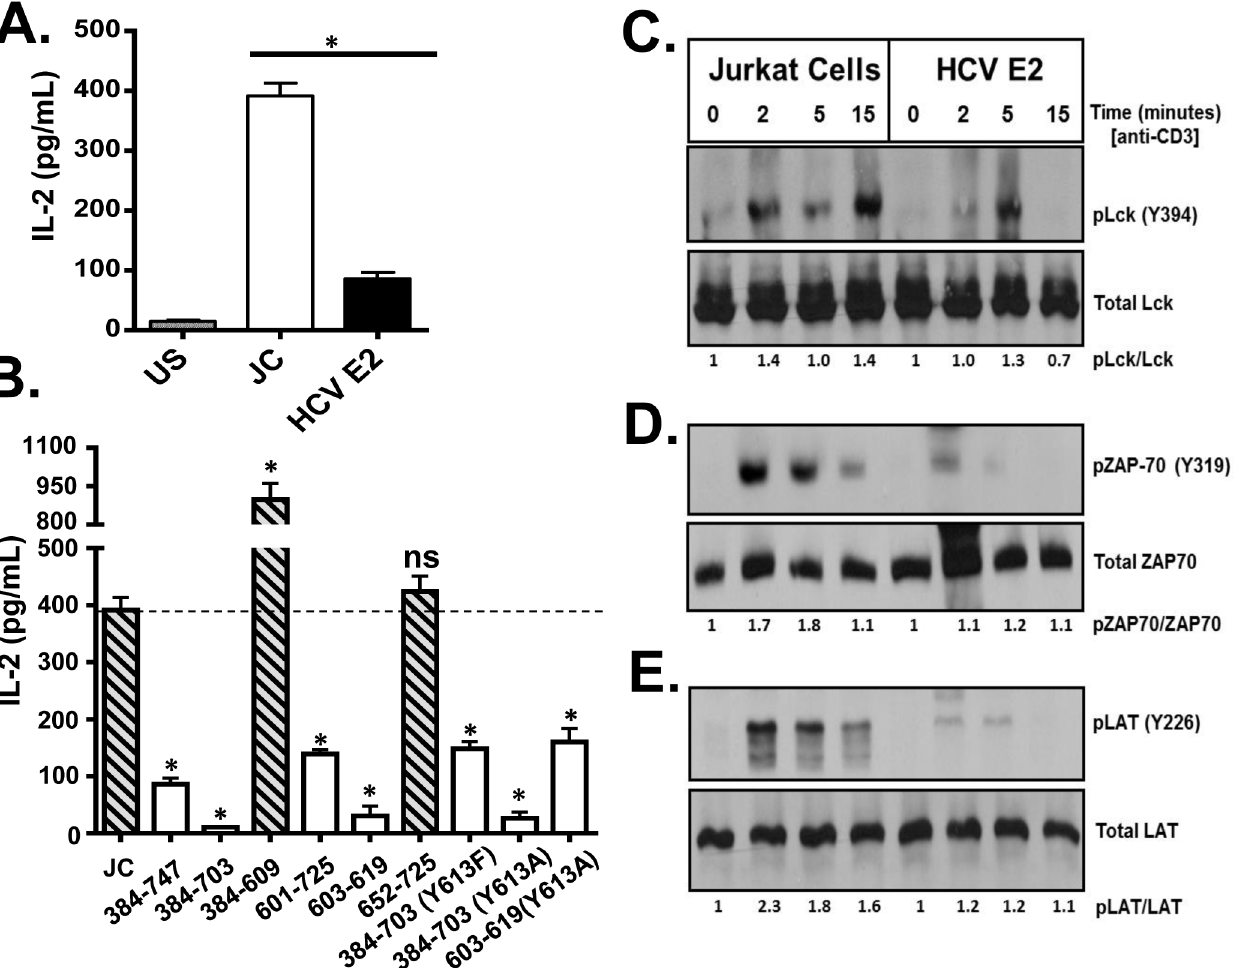
Fig 4. HCV envelope protein E2 inhibits T cell receptor (TCR)-mediated signaling. Jurkat control cells (JC) or Jurkat cells stably expressing HCV E2 protein were stimulated with anti-CD3 and anti-CD28. Twenty-four hours later, IL-2 release (A) was measured. Phosphorylation and activation of the lymphocyte specific tyrosine kinase (Lck Y394; B), the zeta-chain-associated protein kinase (ZAP)-70 (Y319; C) and linker for activation of T cells (LAT, Y226; D) was analyzed in HCV E2 expressing Jurkat cells compared to the controls (JC) following TCR activation using anti-CD3. IL-2 released in truncated or substitution mutant HCV E2 proteins expressing Jurkat cells are shown in panel E. The amino acid numbers relate to their location on the HCV polyprotein. Phospho-blots for Lck, ZAP-70 and LAT were performed at least three times with consistent results. Data represent the average of three technical replicates and the standard deviation is shown. Each experiment was independently performed three times with consistent results. * P < 0.01, ns = not